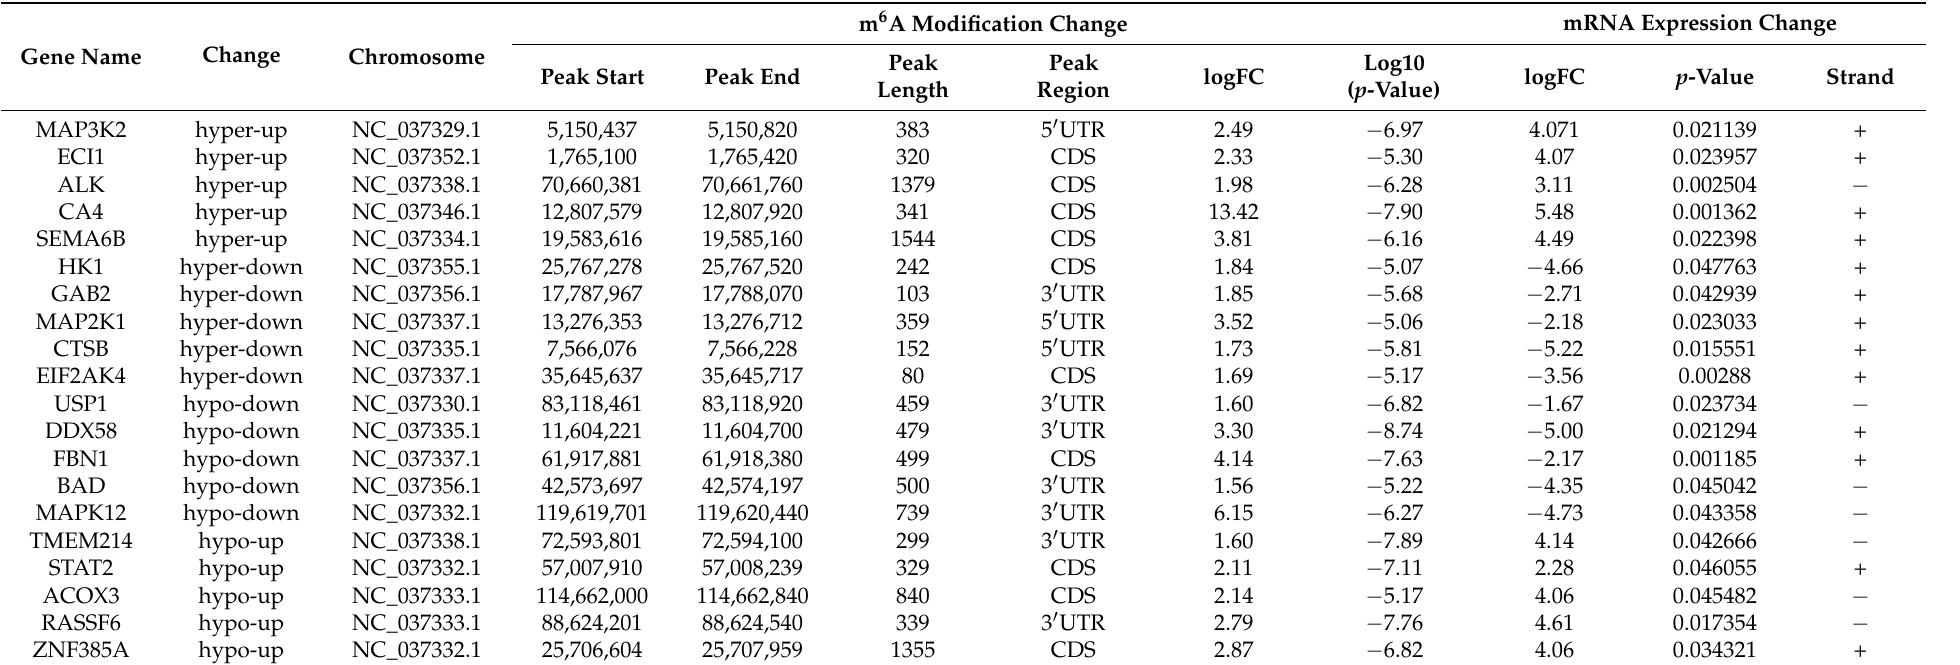
Table 3. All 20 transcripts of differential m 6 A modification and mRNA expression in E. coli vs.